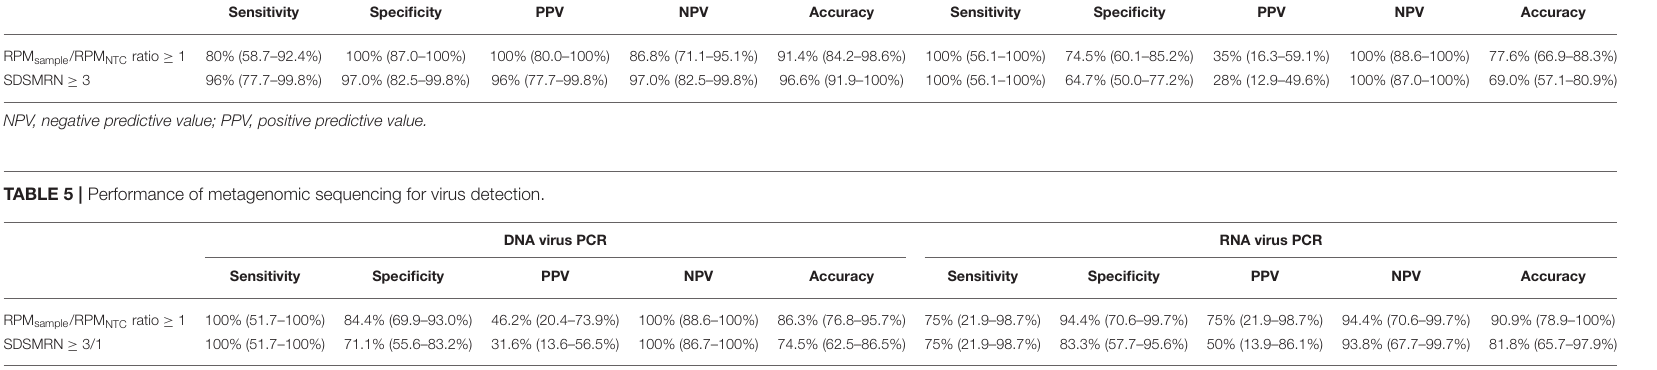
TABLE 4 | Diagnostic performance of metagenomic sequencing for Pneumocystis jirovecii pneumonia. Pneumocystis jirovecii PCR